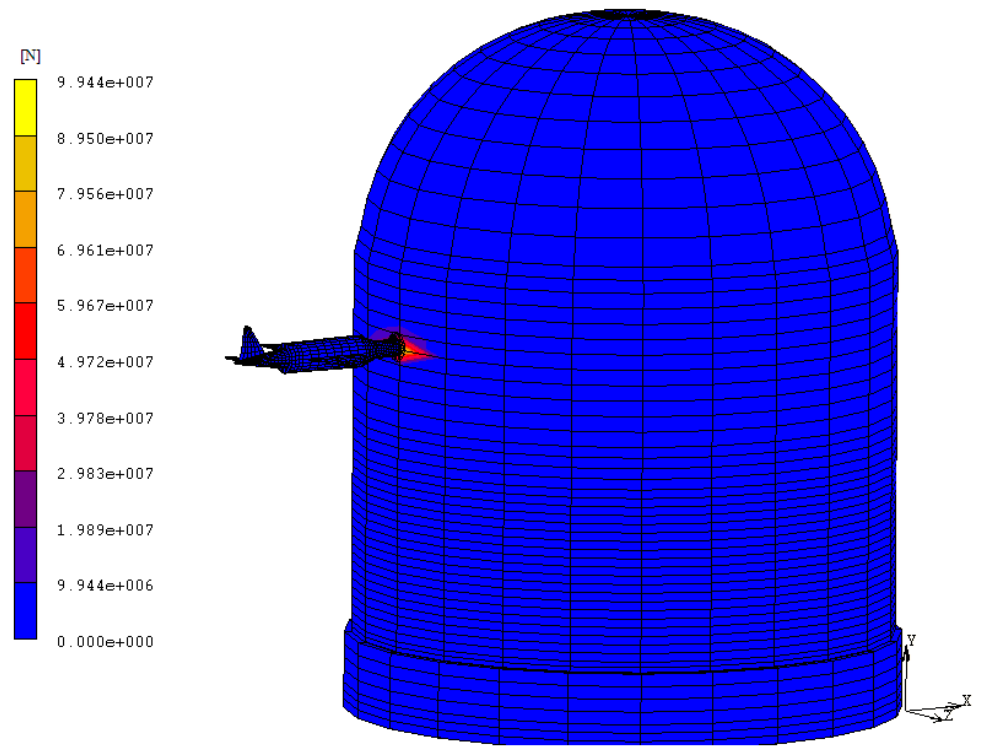
Figure 9. Impact force on target.